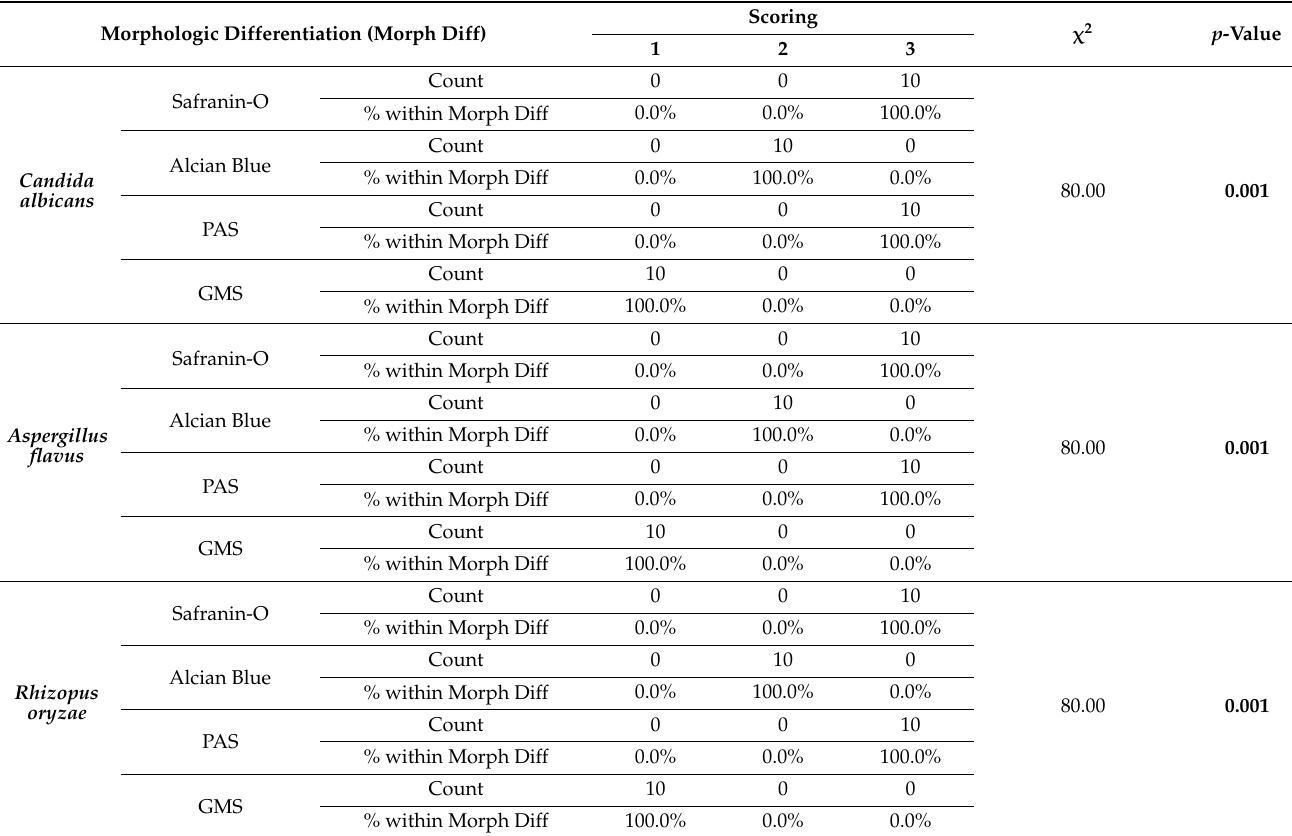
Table 5. Comparison of mean morphologic differentiation (spore shape) of Candida albicans , Aspergillus flavus and Rhizopus oryzae